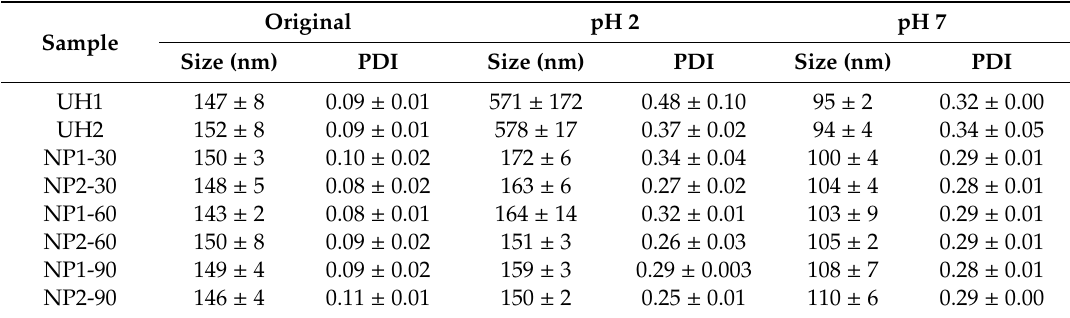
Table 1. Particulate characteristics of nanoparticles and colloidal stability under pH 2 and pH